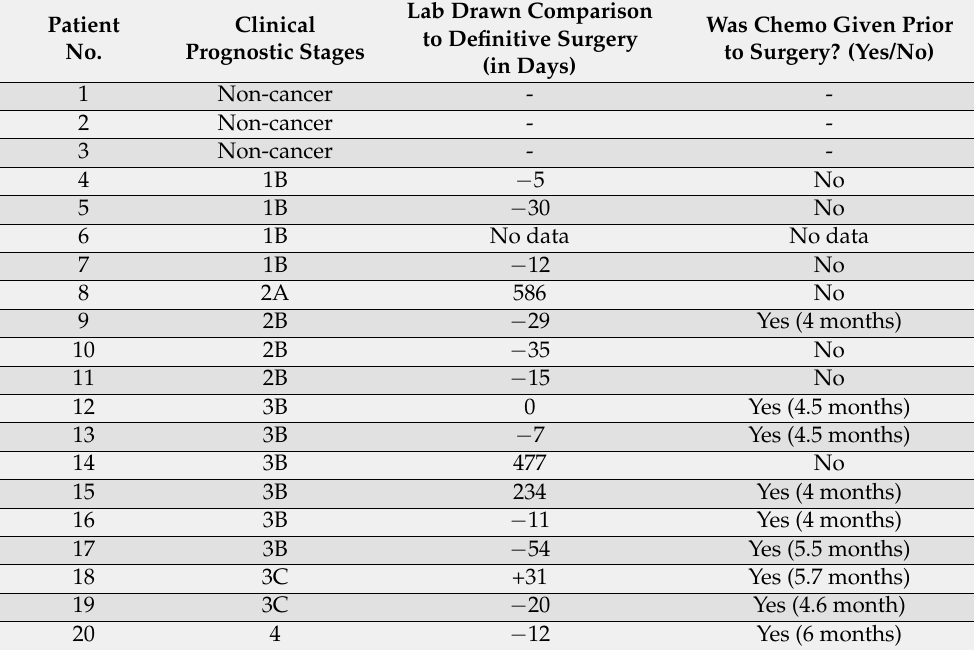
Table 3. Patients’ chemotherapy chemotherapy or surgery information and time of sample collection: 3 normal serum samples and 17 TNBC patient samples with information about their clinical prognostic stages, duration of blood drawn—before or after surgery, and the period they underwent